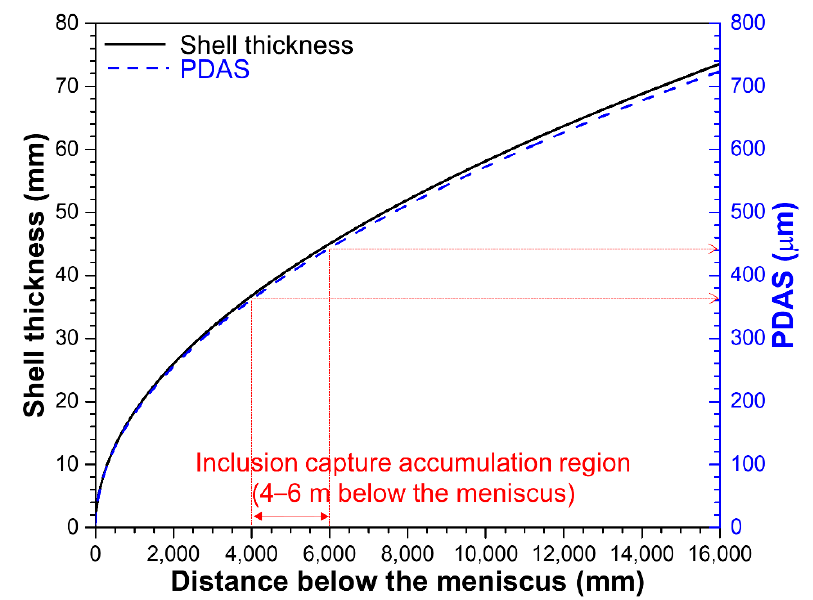
Figure 3. Solidifying steel shell thickness and Primary Dendrite Arm Spacing (PDAS)